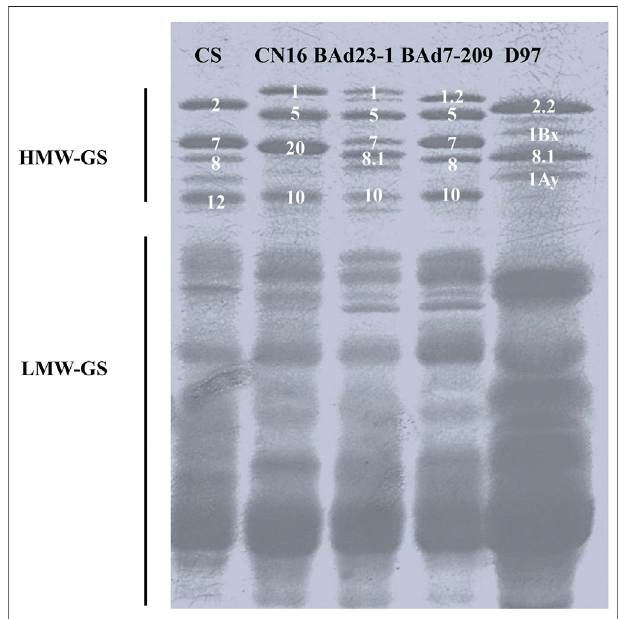
FIGURE2| Separation ofgluteninproteins from BAd7-209and BAd23- 1 and their parents by SDS-PAGE and ChineseSpring(CS) asthe references.